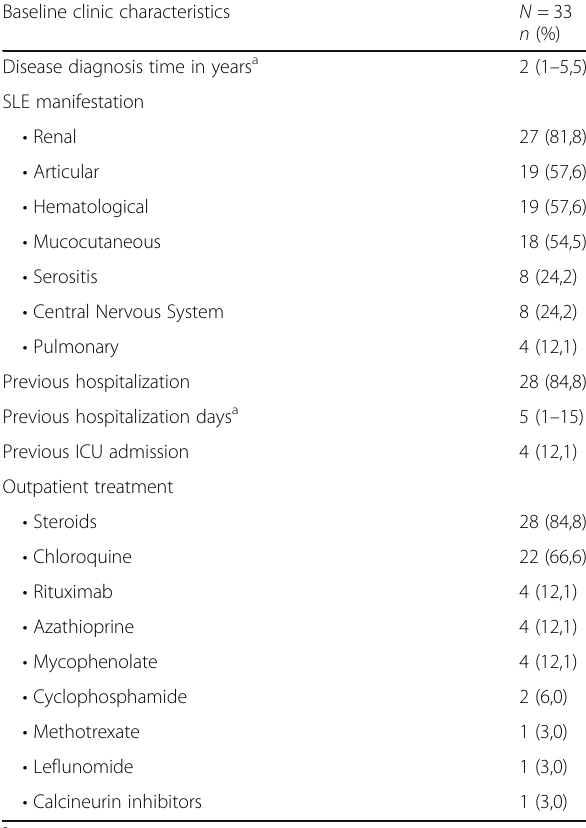
Table 2 Baseline clinical characteristics Baseline clinic characteristics